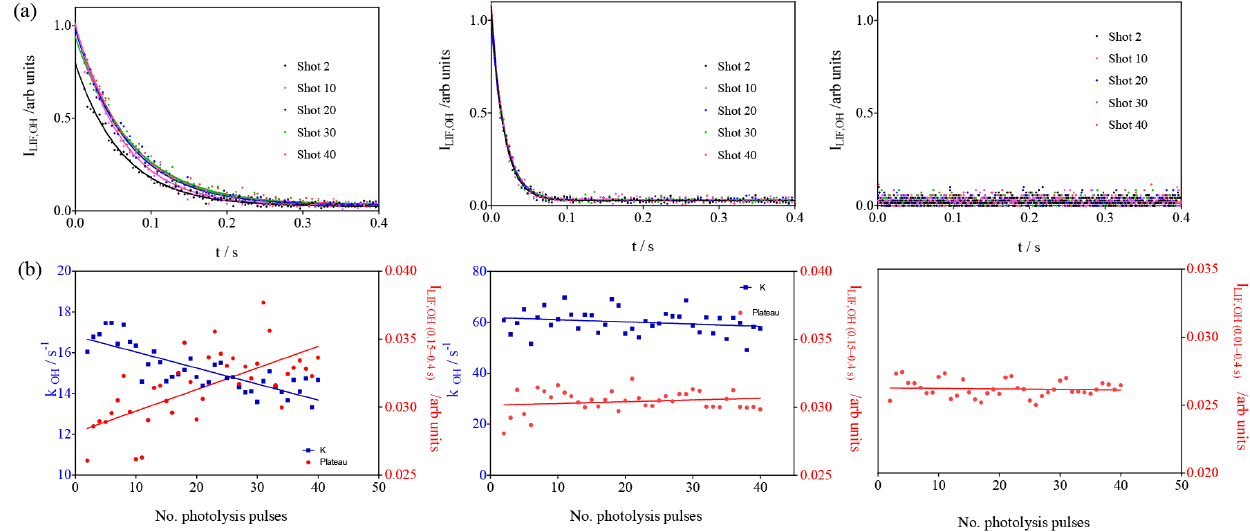
Figure 7. Photolysis of O 3 in the presence of different concentrations of n-butane (7 × 10 12 , 2 × 10 13 and 7.5 × 10 15 cm − 3 from left to right). (a) OH decays (for clarity only every 10th decay is shown); (b) decay rates of OH radicals as a function of photolysis pulses (blue dots, left y axis), residual LIF intensity taken from mono-exponential fit for left graphs and as the average LIF intensity between 0.15 and 0.4s and 0.01 and 0.4s for the centre and right graphs, respectively.